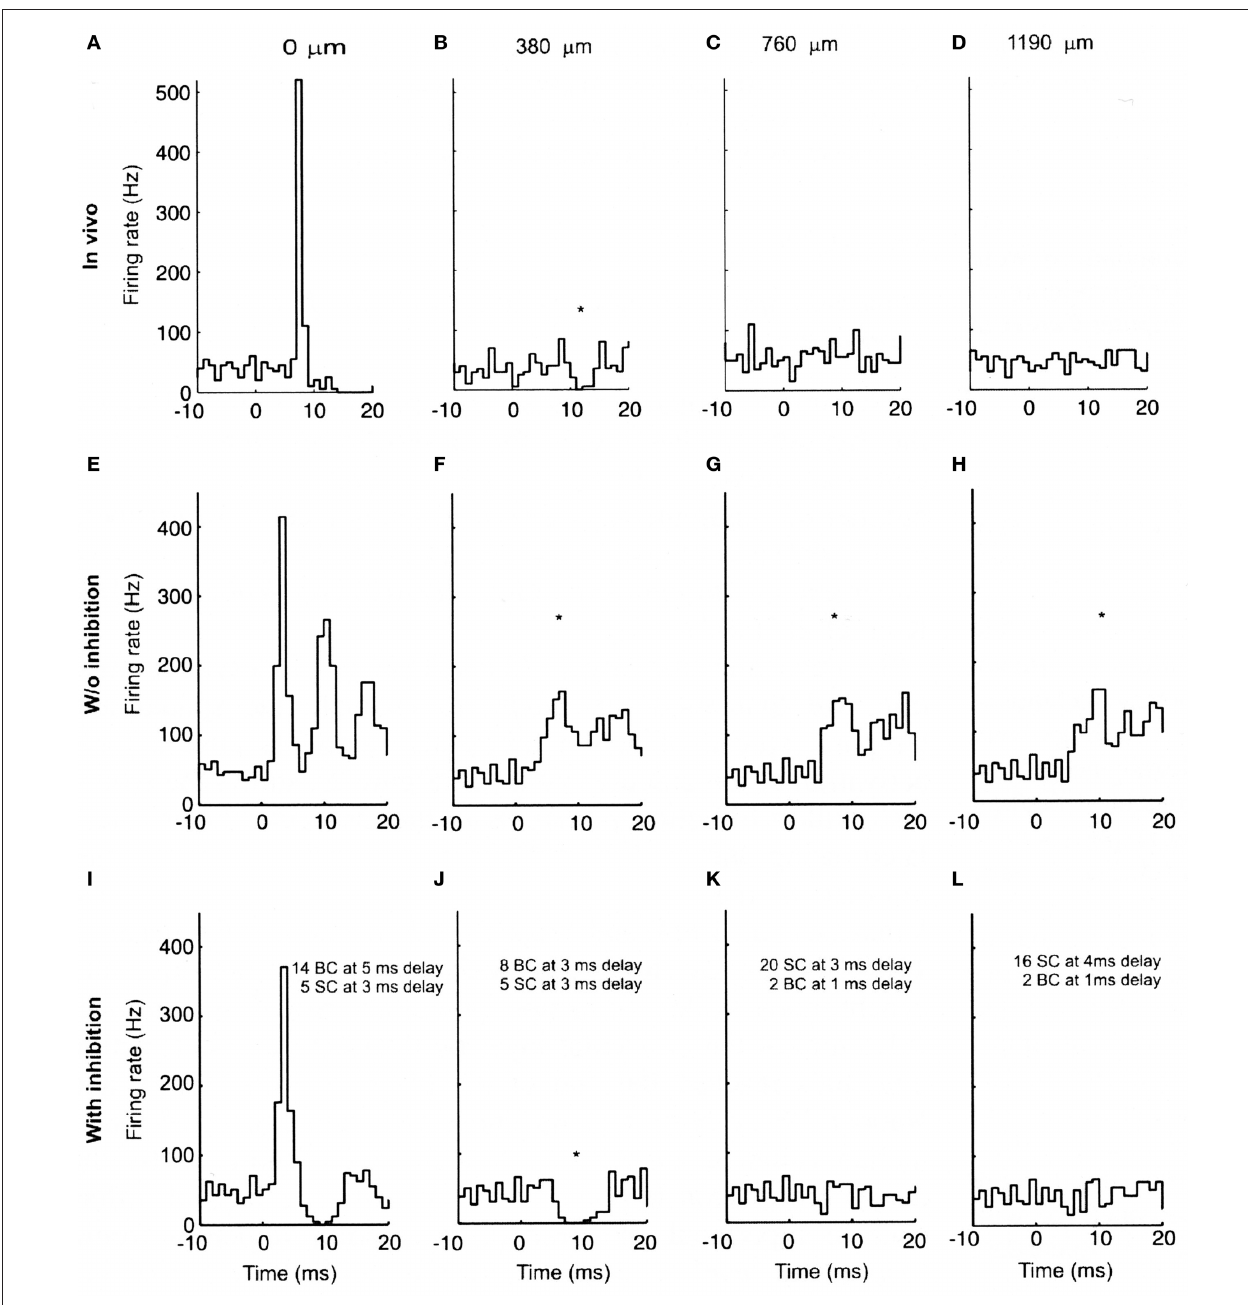
indicate the inhibitory conduction delays as well as the number of basket (BC) and stellate cell (SC) synapses converging on the corresponding PCs. All simulated Purkinje cells received randomly activated excitatory and inhibitory synapses resulting in an average spontaneous firing frequency of 40 Hz. The difference in the delay in the excitatory onset latency in the in vivo (A) and modeled ( e and i ) PCs is due to the additional conduction delays from the stimulated skin to the cerebellum in vivo , which for simplicity were not included in the model. The * denotes statistically significant difference from background activity (T-test, p < 0.05). Reproduced with permission from Santamaria et al.,